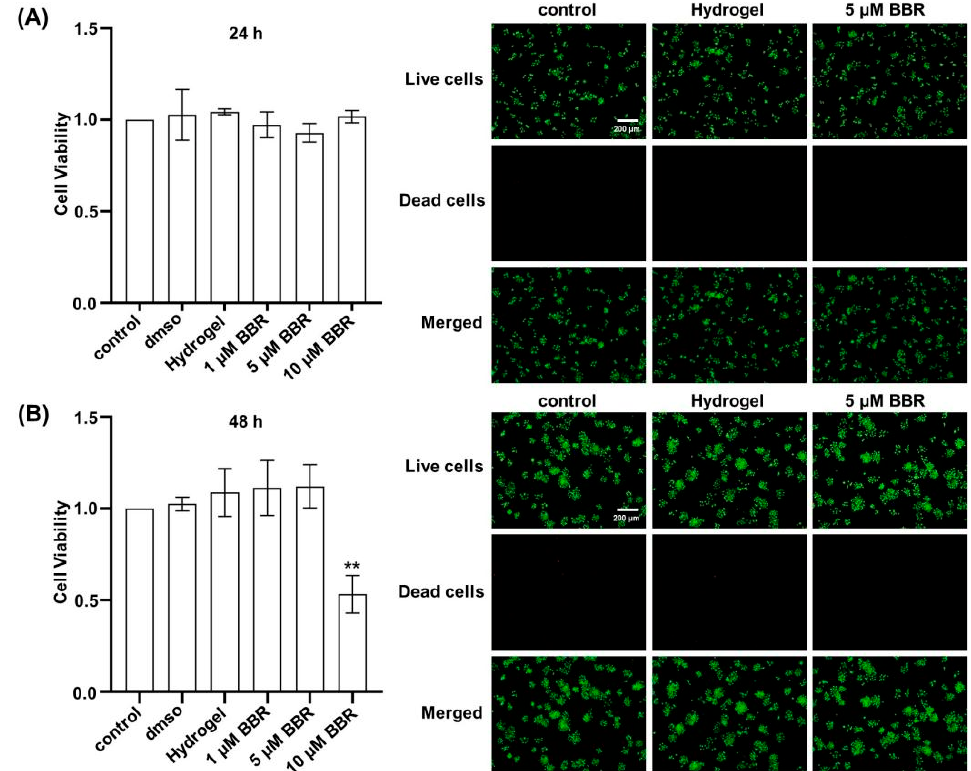
Figure 2. Cytotoxicity of berberine-loaded CS/ β -GP/SA thermosensitive hydrogel in RAW 264.7 cells. Viability of RAW 264.7 cells cultured with berberine-loaded CS/ β -GP/SA thermosensitive hydrogel at different concentrations (1–10 µM) at 24 h ( A ) and 48 h ( B ). Green represents living cells, and red represents dead cells. **: p < 0.01.